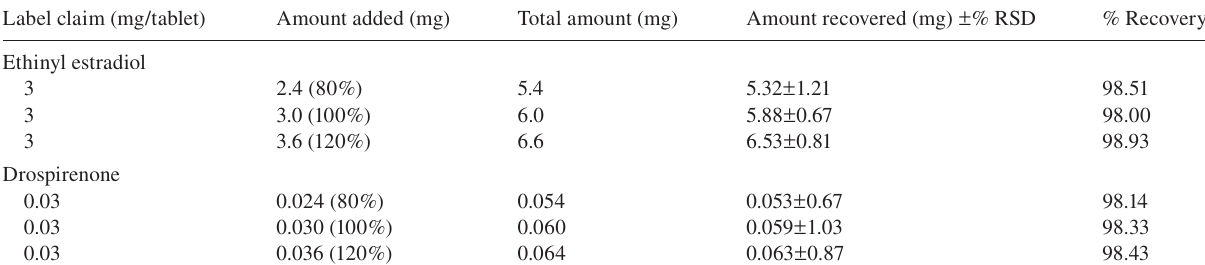
Table 3 Recovery studies (n = 6).